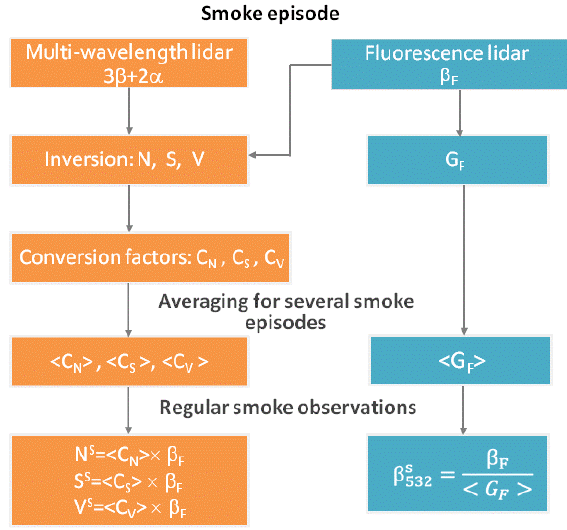
Figure A1. Flow chart showing the main steps of the procedure of smoke parameter estimation from multiwavelength Mie–Raman and fluorescence lidar measurements. Procedure includes the fol- lowing steps. (i) For a strong smoke layer the 3 β + 2 α data set, derived from multiwavelength Mie–Raman lidar observations, is in- verted to the particle number N , surface S and volume V density. (ii) Conversion factors C N , C S and C V are calculated from Eq. (2) by using the fluorescence backscattering coefficient β F . (iii) Dif- ferent smoke events are analyzed to get mean values of conversion factors (cid:104) C N (cid:105) , (cid:104) C S (cid:105) and (cid:104) C V (cid:105) . These mean values are used to esti- mate smoke concentration in weak layers in UTLS and inside cirrus clouds in regular observations. The mean value of smoke fluores- cence capacity (cid:104) G F (cid:105) allows the estimation of smoke